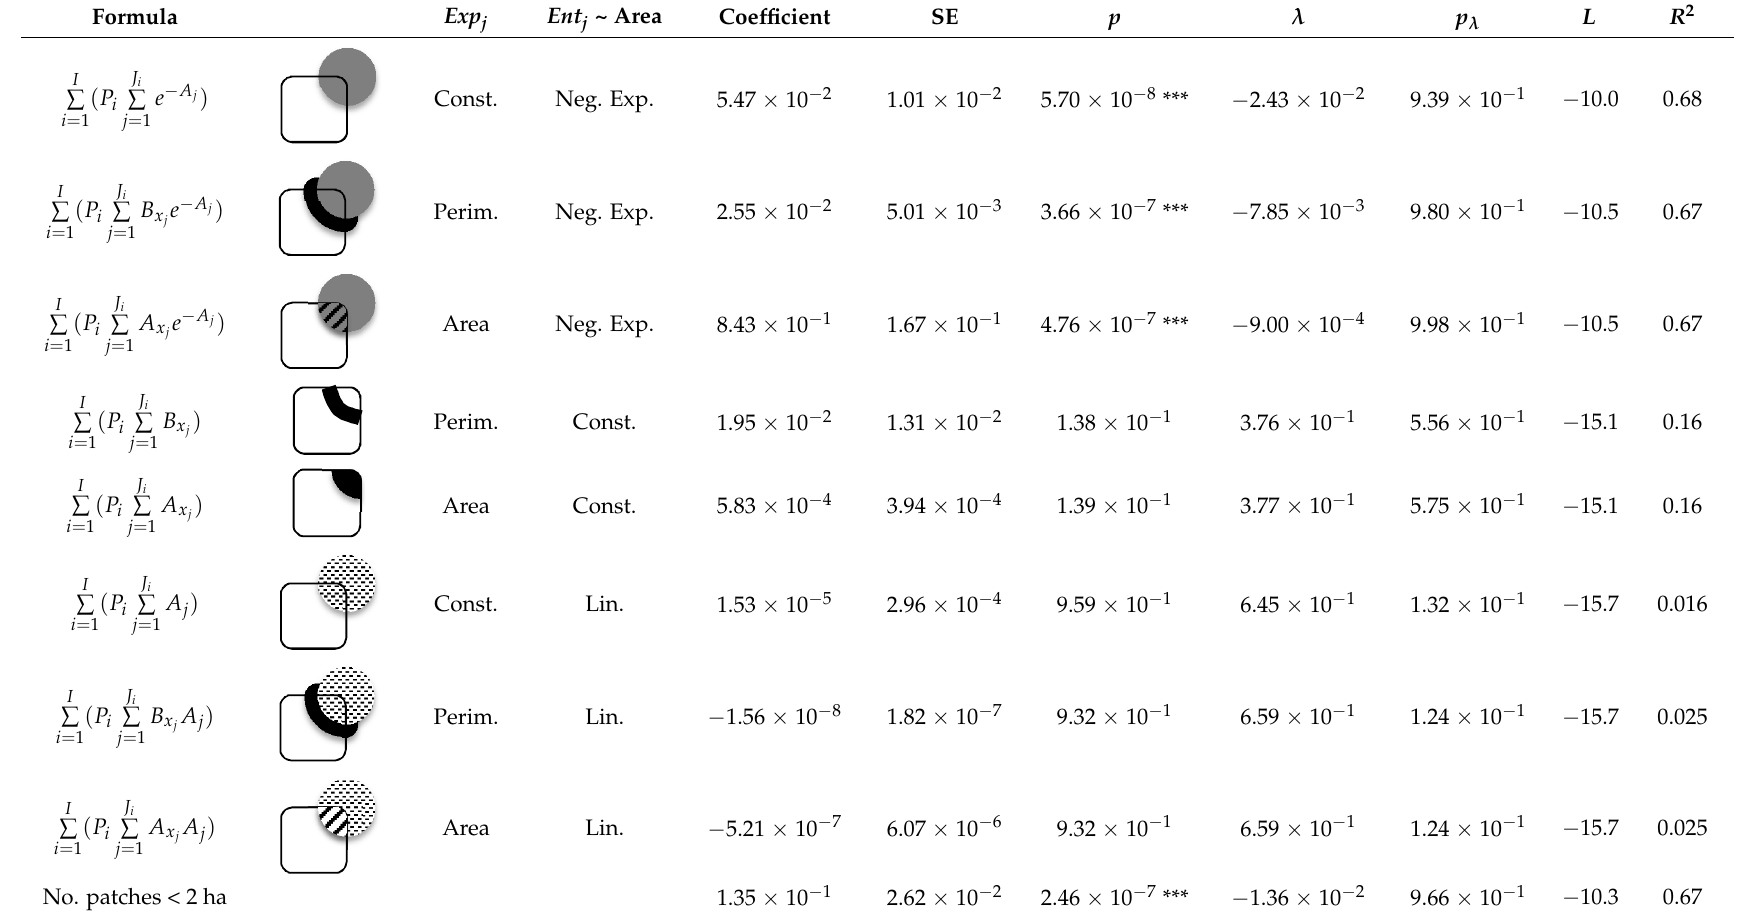
Table 2. Explanatory power of tract-level landscape variables.